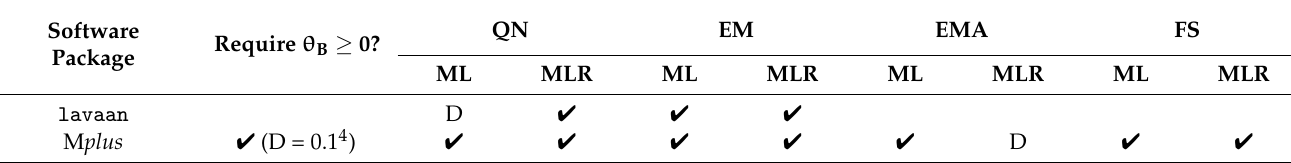
Table 1. Availability of estimation options in lavaan and M plus